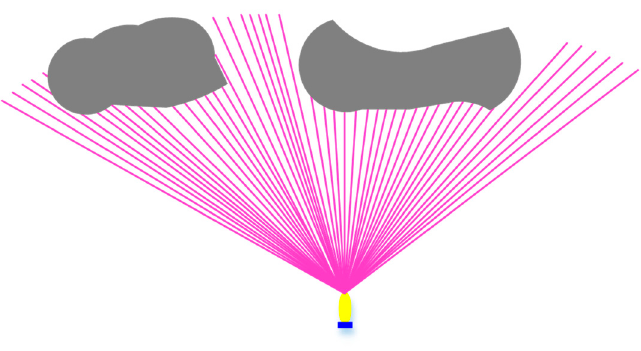
Figure 5. Example of FLS detecting data grouped.